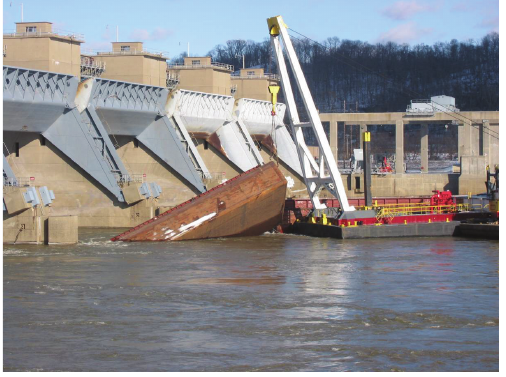
Figure 4: Barge impact at Belleville Locks and